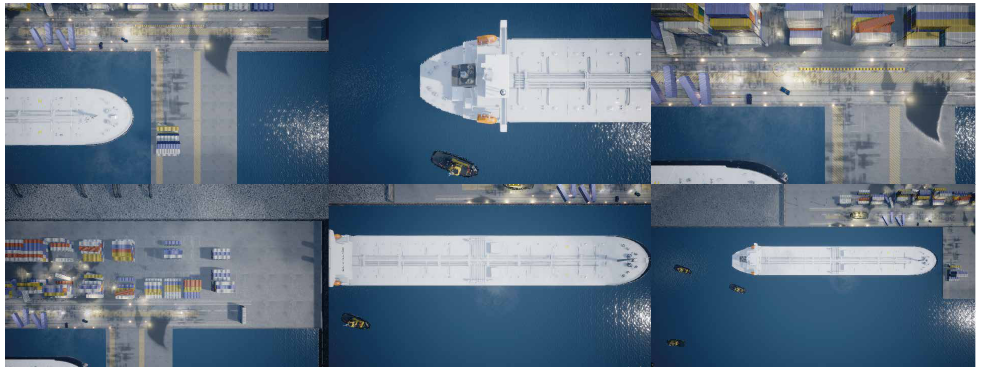
Figure 15. Examples of images in dataset version 1.1